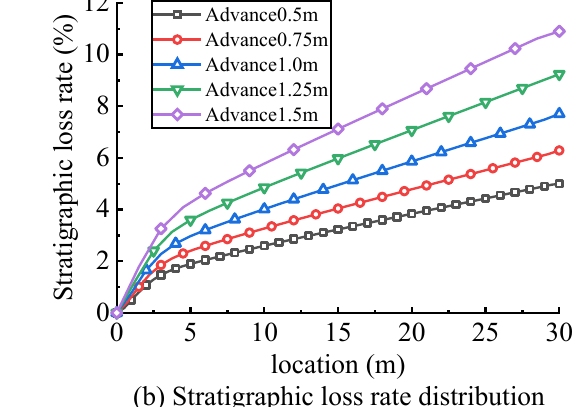
Keeping the other design parameters unchanged, Figure 10 shows the distribution curves of the formation loss rate and maximum surface subsidence for an excavation footage length per cycle of 0.5, 0.75, 1, 1.25, and 1.5 m. The influence of the excavation footage length on the pre-support effect was also analyzed.